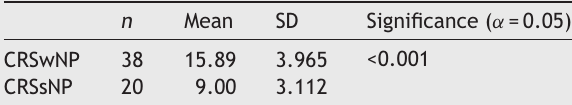
Spearman coefficient and significance (two-tailed) for correlation between individual items and total score of